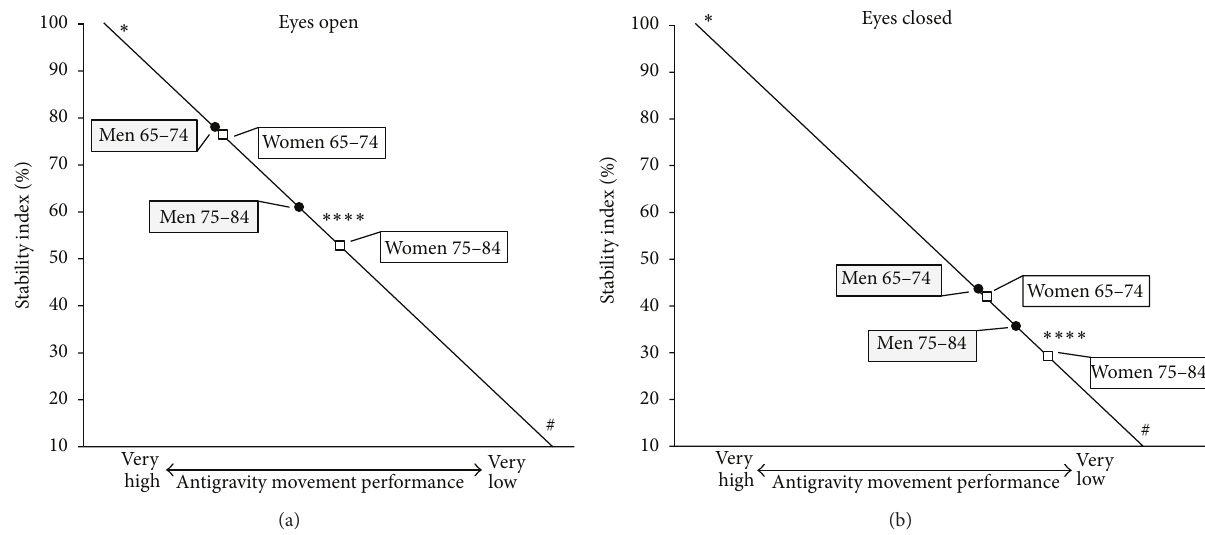
Figure 7: Single (ST). Postural and proprioceptive control: age and gender relations. The age groups of the study are positioned according to their ST level (a) in eyes open (indicator of postural control) and (b) in eyes closed (indicator of proprioceptive control). ∗ Olympic and world champion level; # walking impossible without aid; ∗∗∗∗ 𝑃 < 0.001